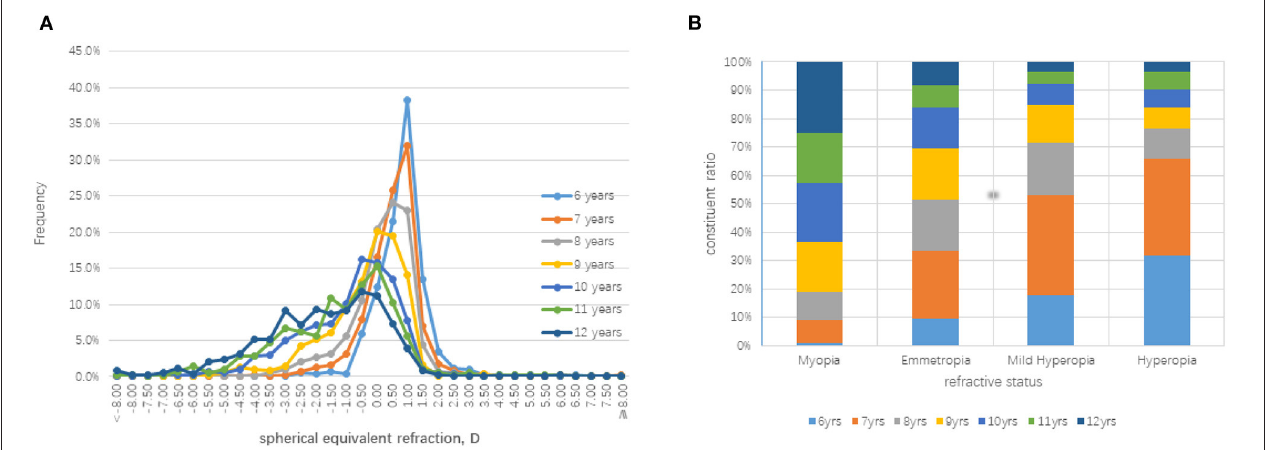
FIGURE 1 | Distributions of the cycloplegia spherical equivalent refraction (SER) in the right eye of the each age group. (A) The frequency distributions of SER among different age children. (B) The composition ratio of different ages children among the different refractive error